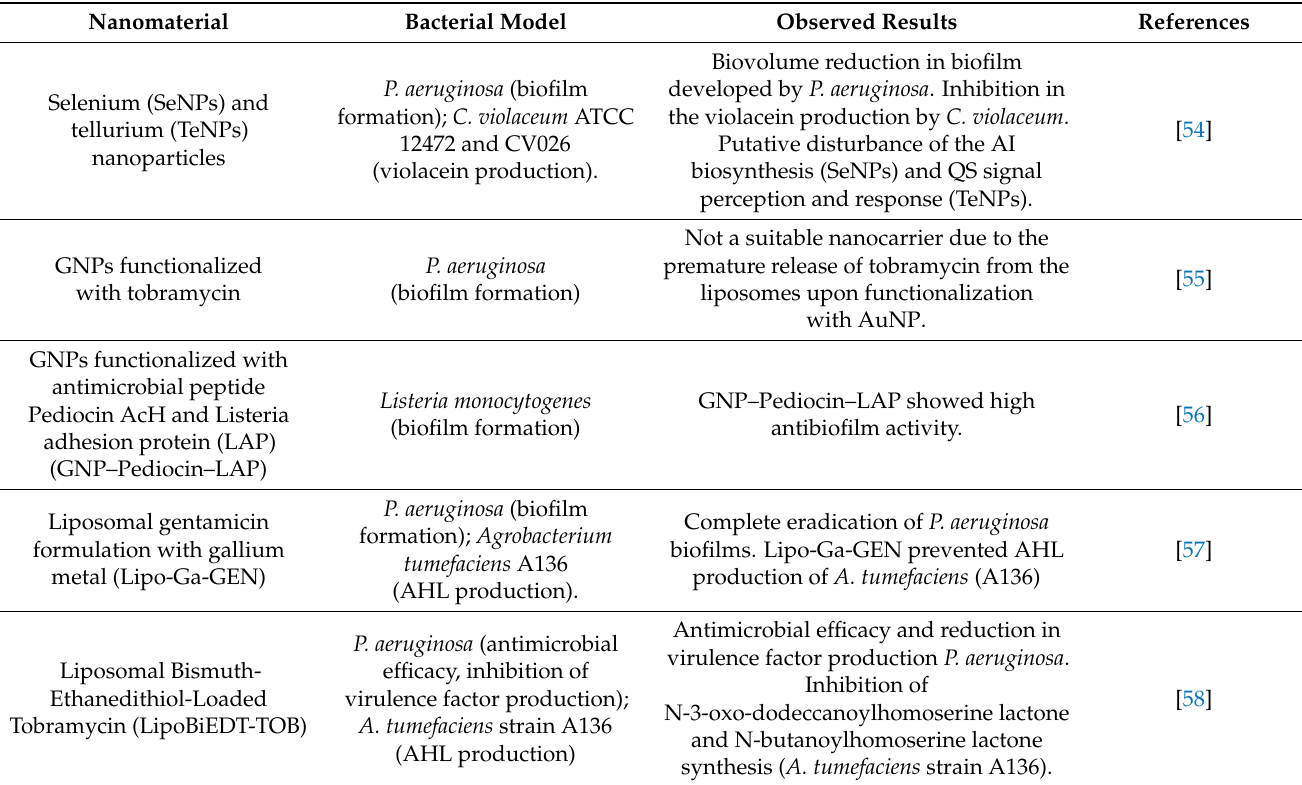
Table 2. Representative examples of nanoparticles or drugs functionalized with nanoparticles devel- oped to produce bacterial biofilm